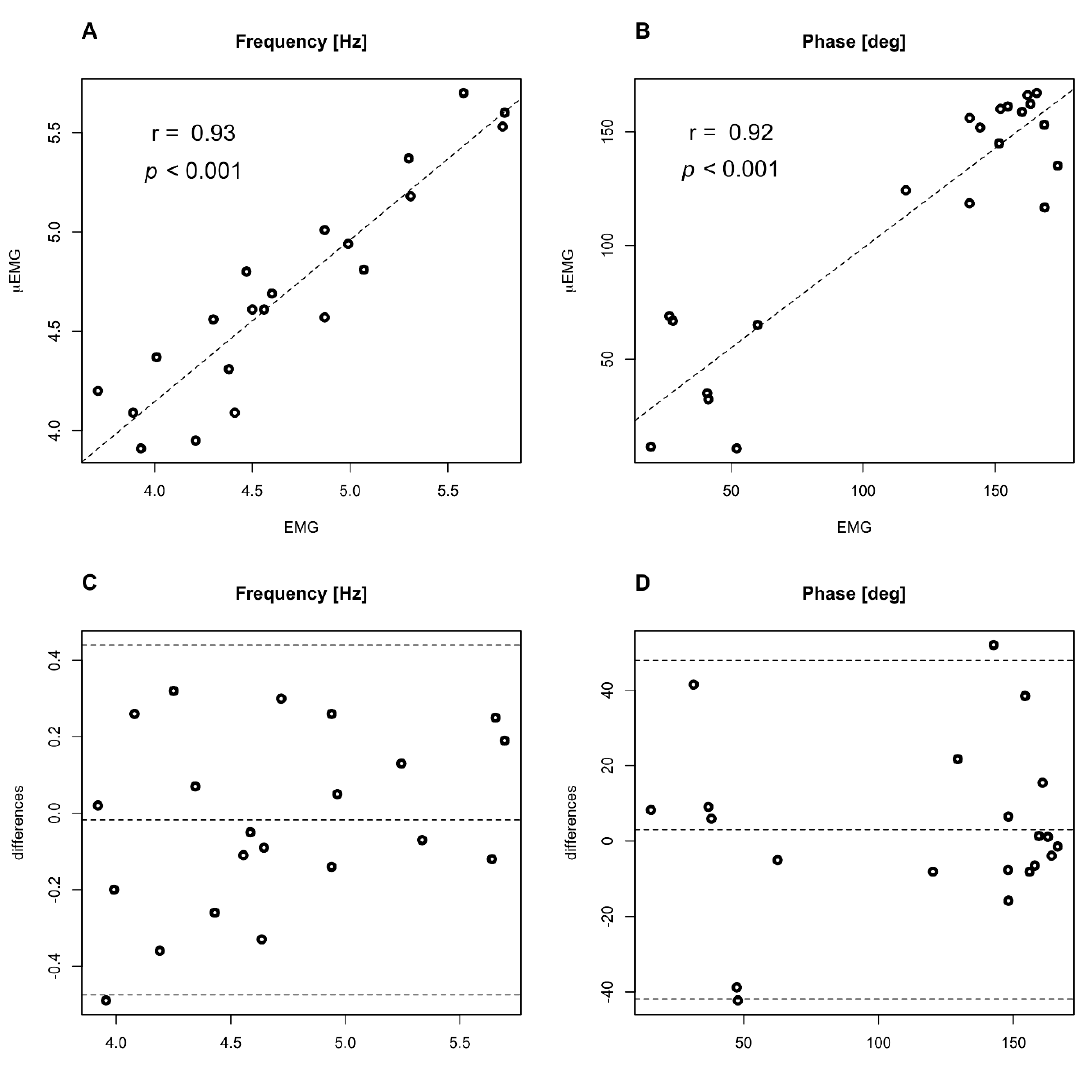
Figure 4. Comparison of measurements from Dantec Keypoint EMG and µEMG experimental wearable device. Correlation plots for ( A ) Frequency and ( B ) phase differences; Bland–Altman plots with 95% confidence interval for ( C ) Frequency and ( D ) phase differences. EMG: electromyography.